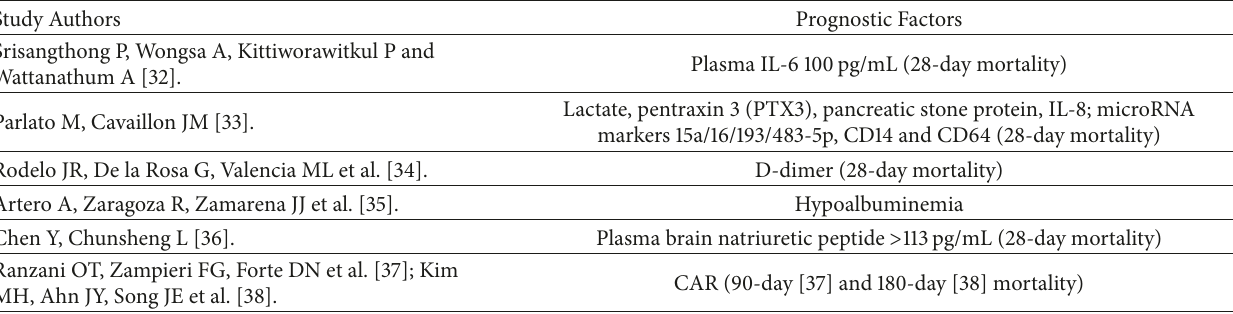
Table 4: Prognostic factors for predicting sepsis mortality after two-stage